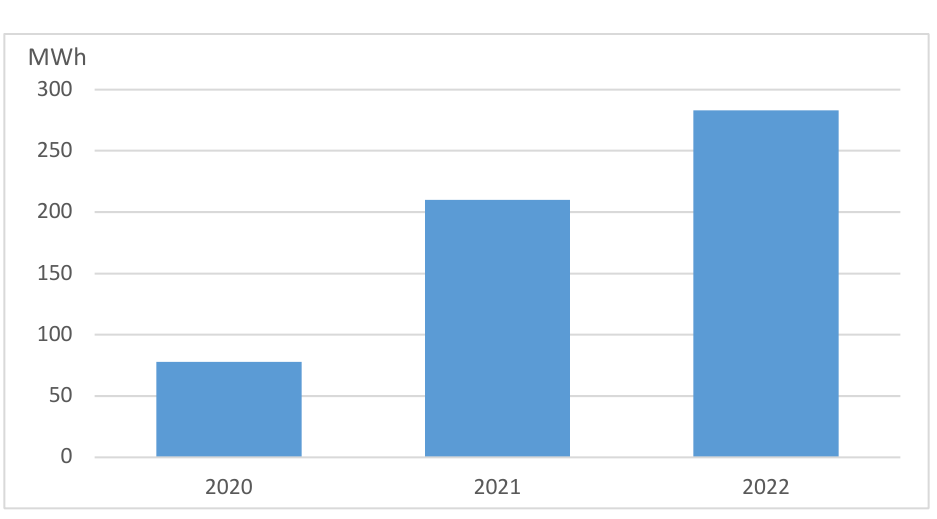
Figure 8. Relevant data concerning the EV charging sessions in Cluj - Napoca between January 2020 and June 2022.